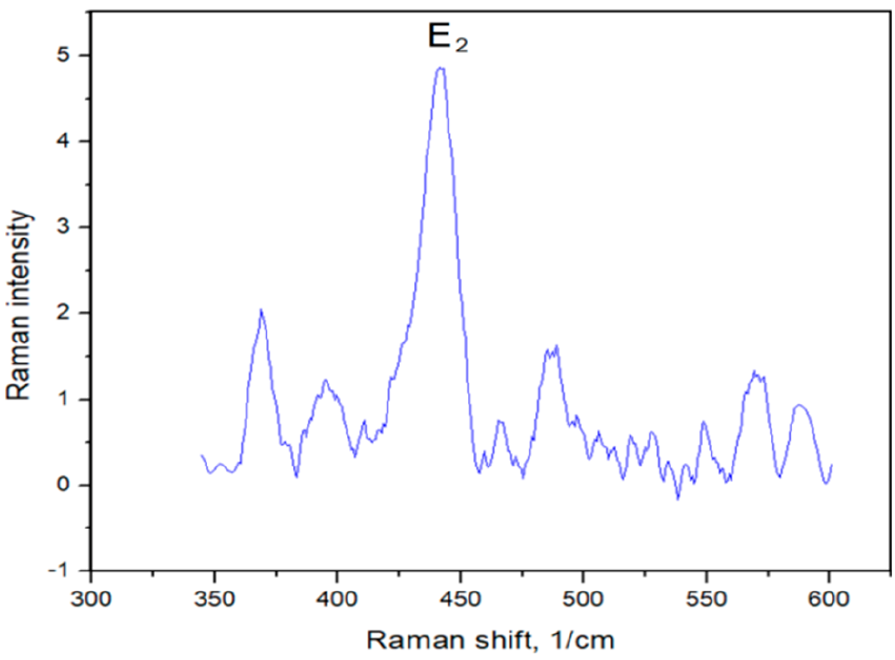
Figure 2. Raman spectra of ZnO nanoparticles.